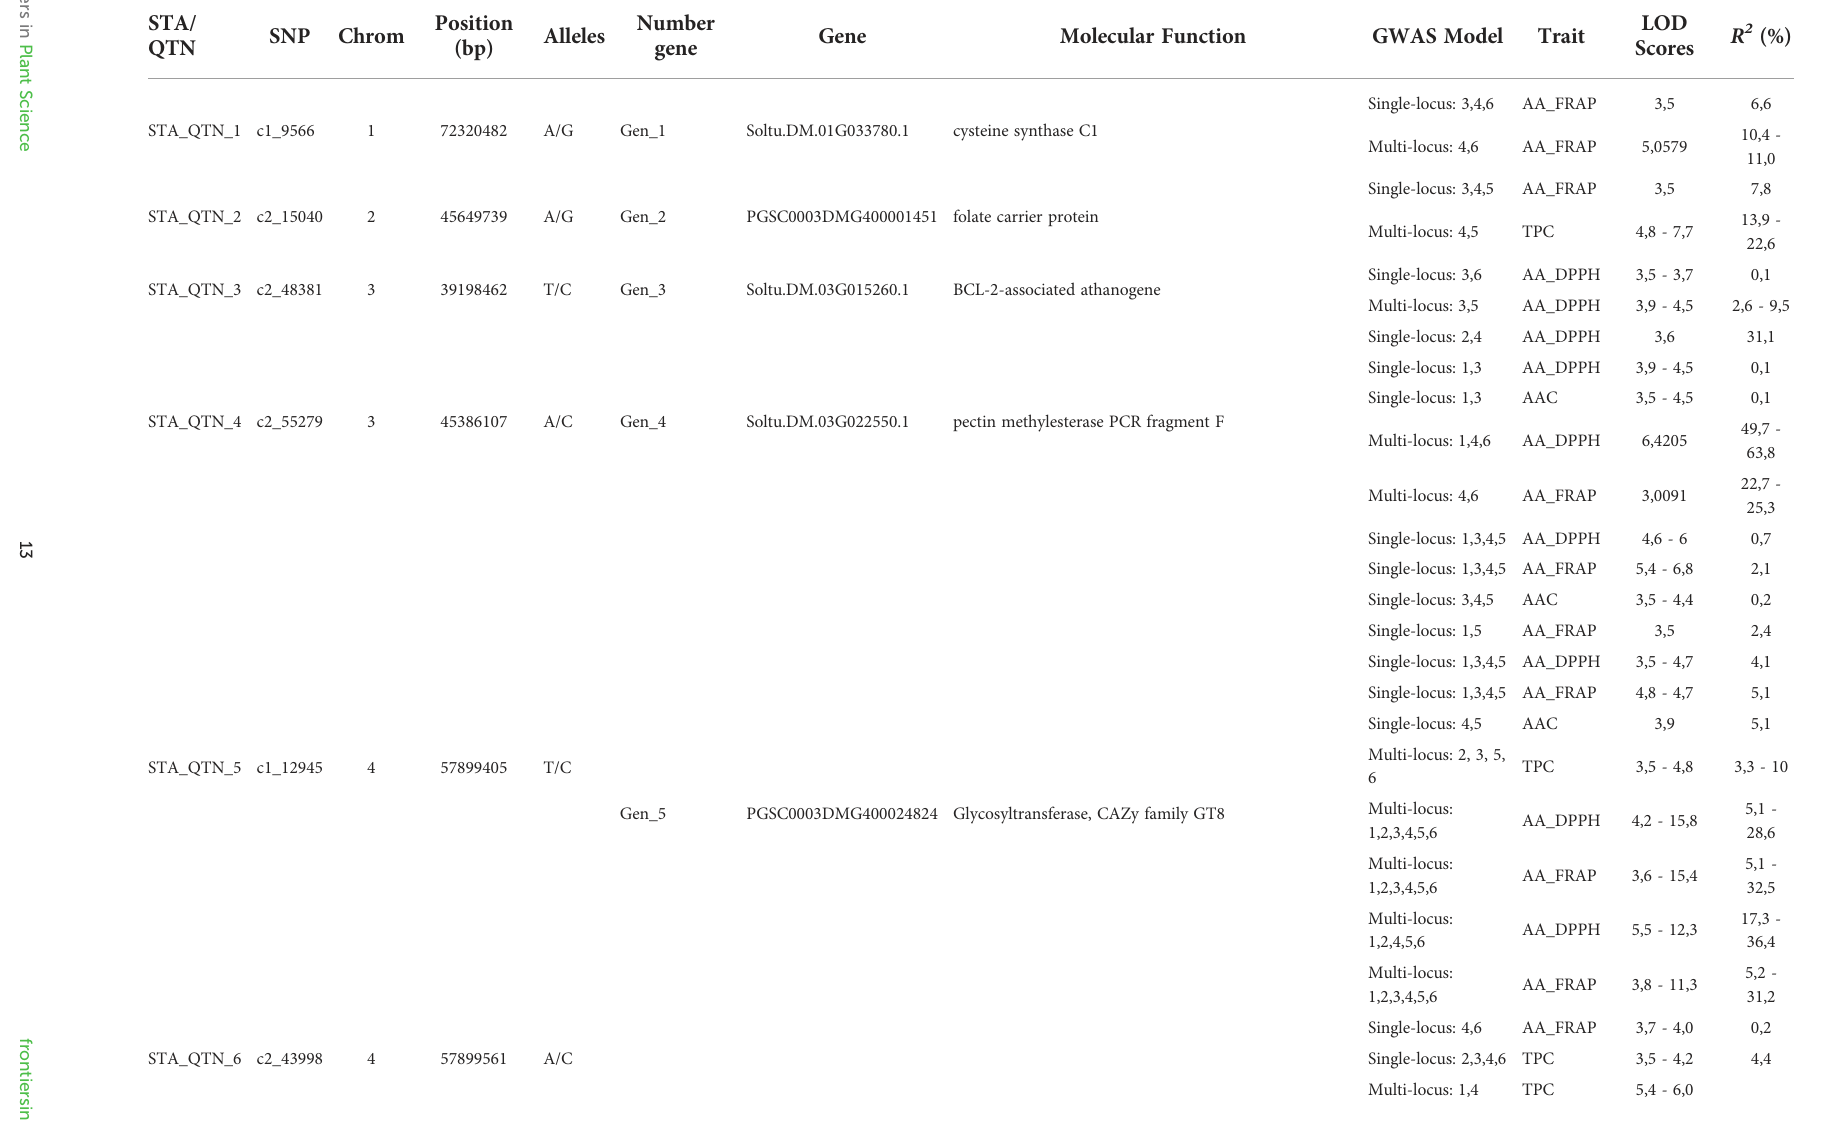
TABLE 2 List of candidate genes obtained from STAs and QTNs detected in common in single and multi-locus GWAS methods with signi fi cant association with the content of phenolic compounds (TPC), ascorbic acid (AAC), and Antioxidant Activity (AA) in potatoes populations.